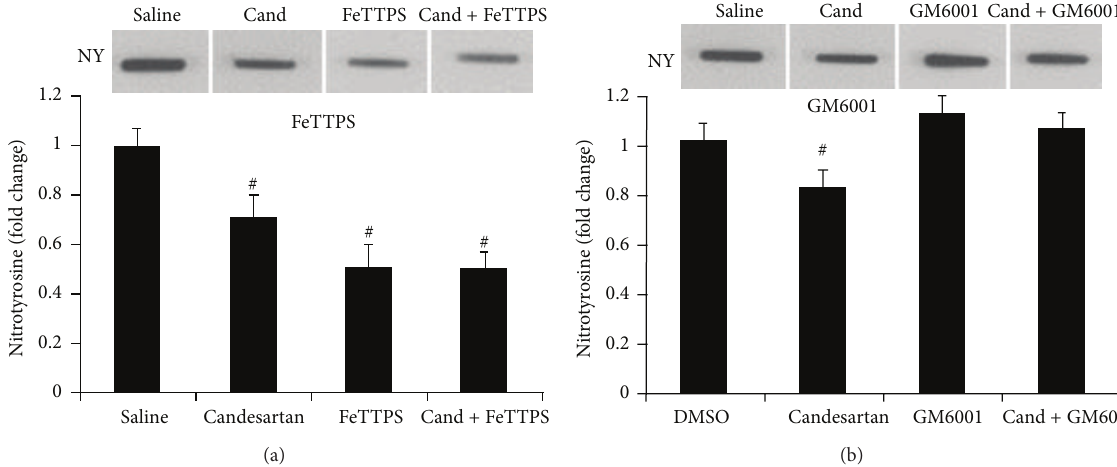
Figure 1: Effects of candesartan alone and in combination with FeTPPS and GM6001 on nitrotyrosine (NT) at 24 h after MCAO. Candesartan, FeTTPS, and their combination demonstrated reduced NT compared to the saline treated group ( # 𝑃 < 0.05 ). Candesartan alone reduced NT compared to DMSO and GM6001 alone, but the candesartan combination with GM6001 blunted the effect of candesartan. Values are mean ± SEM ( # 𝑃 < 0.05 ).